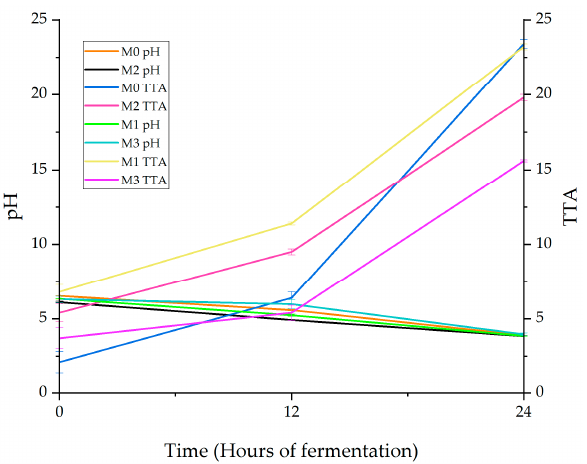
Figure 2. pH and TTA in sourdough with wheat flour (M0), einkorn flour (M1), spelt flour (M2), and emmer flour (M3), fermented for 0, 12, and 24 h with Lactiplantibacillus plantarum ATCC 8014. Results are represented as mean values ± standard deviation (SD); n =